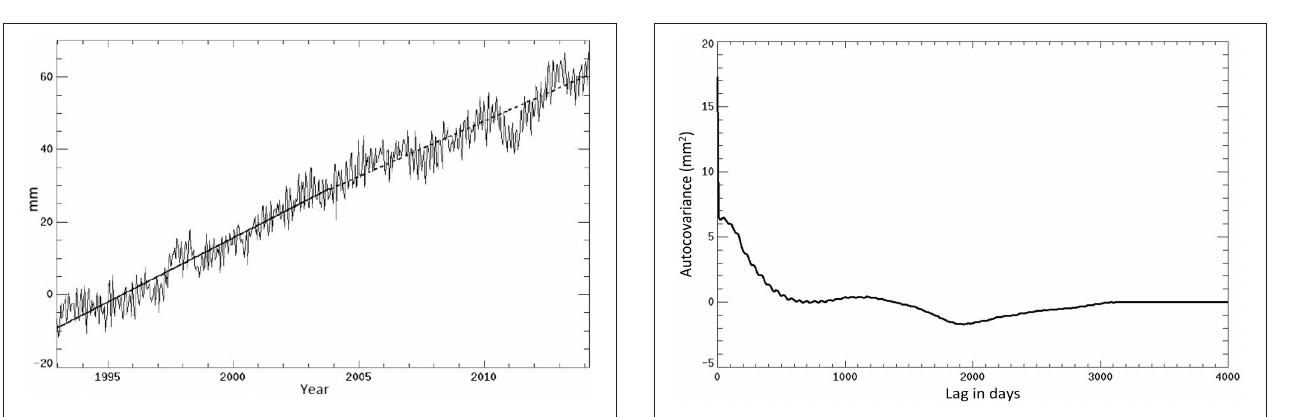
FIGURE 1 | GMSL (in mm) time series in 10-day intervals from 1993–2013, obtained from the altimeter measurements from the TOPEX/Poseidon, Jason-1, and Jason-2 missions (Nerem et al., 2010). The heavy solid and dashed lines represent linear fits of the first and second half of the record, respectively. The standard deviation of the random errors is 4.1mm.